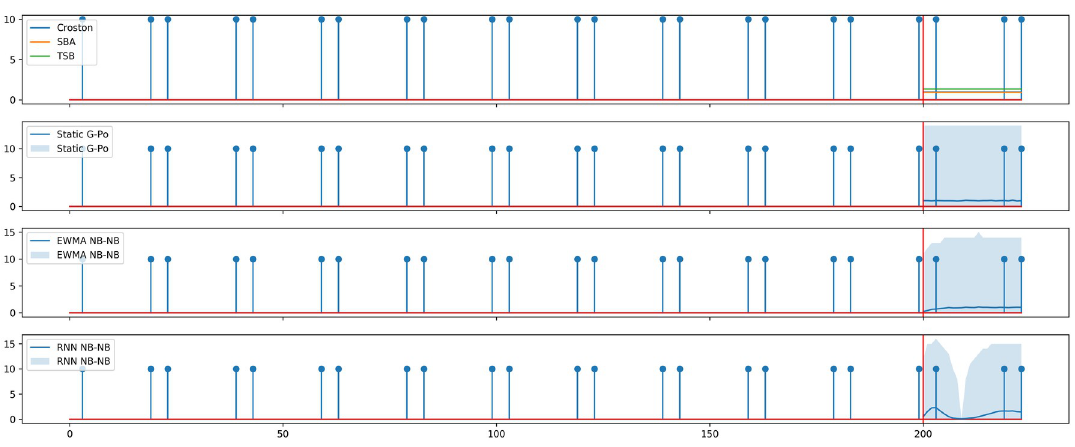
Fig 3. Comparing the forecasts of different IDF approaches on a synthetic data set with alternating